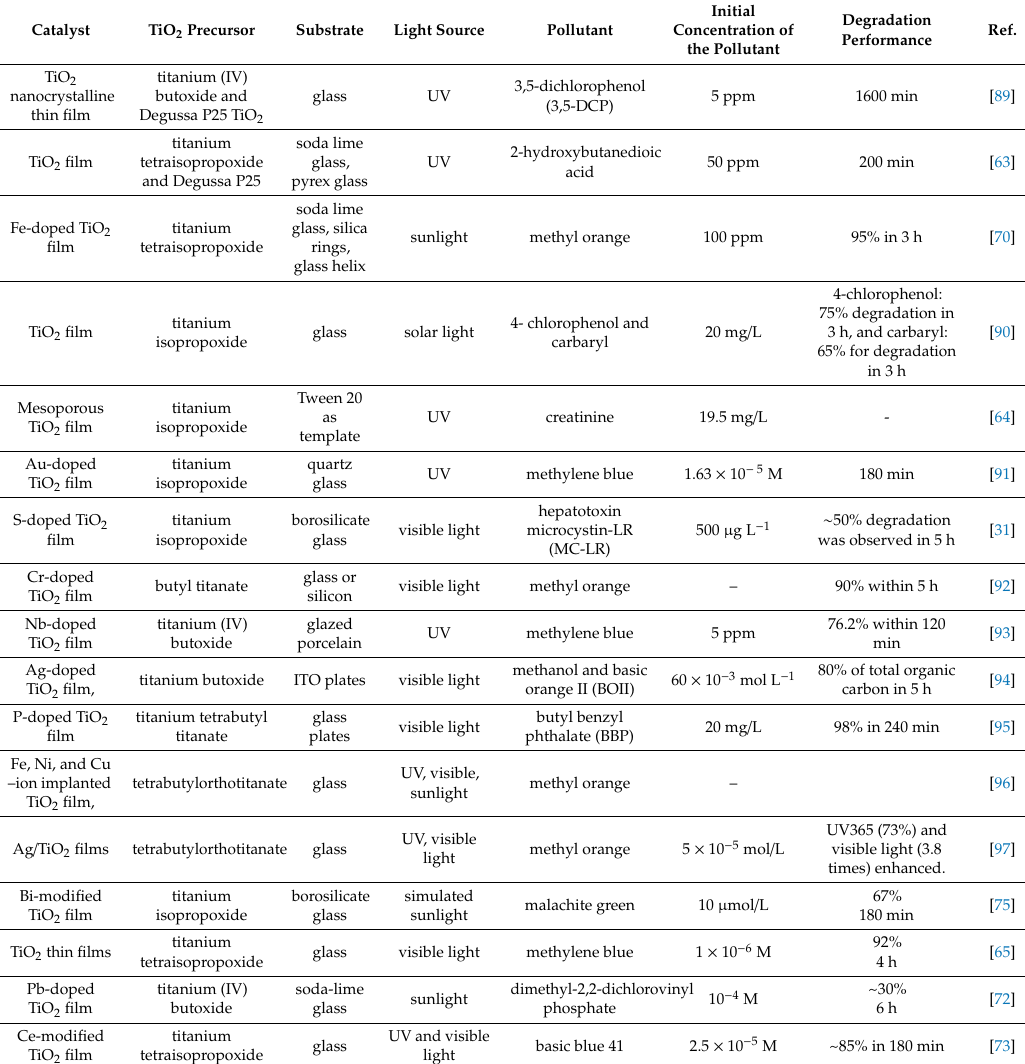
Table 2. Photocatalytic dye degradation performance of various TiO 2 films prepared by sol-gel method.